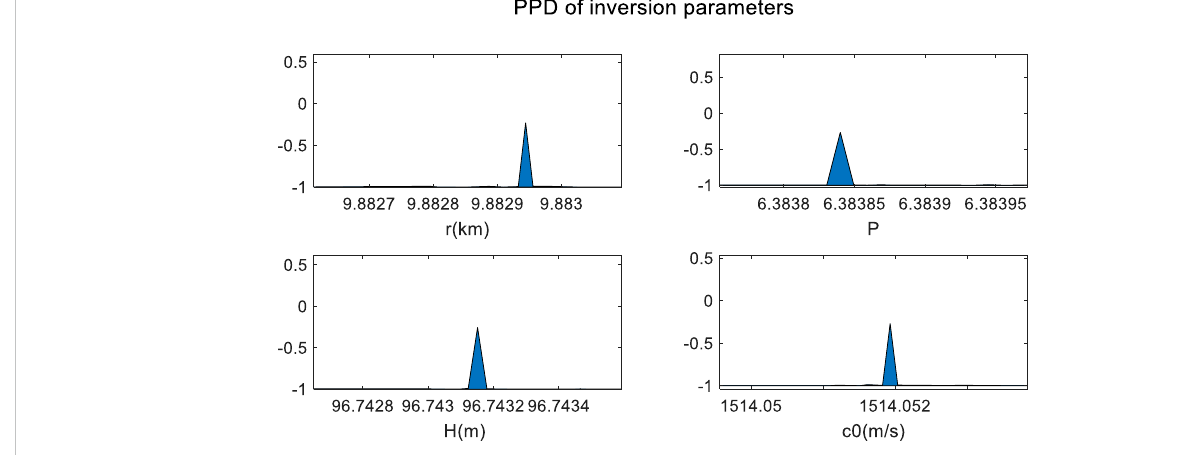
FIGURE 9 The 1-D MPD of inversion parameters.